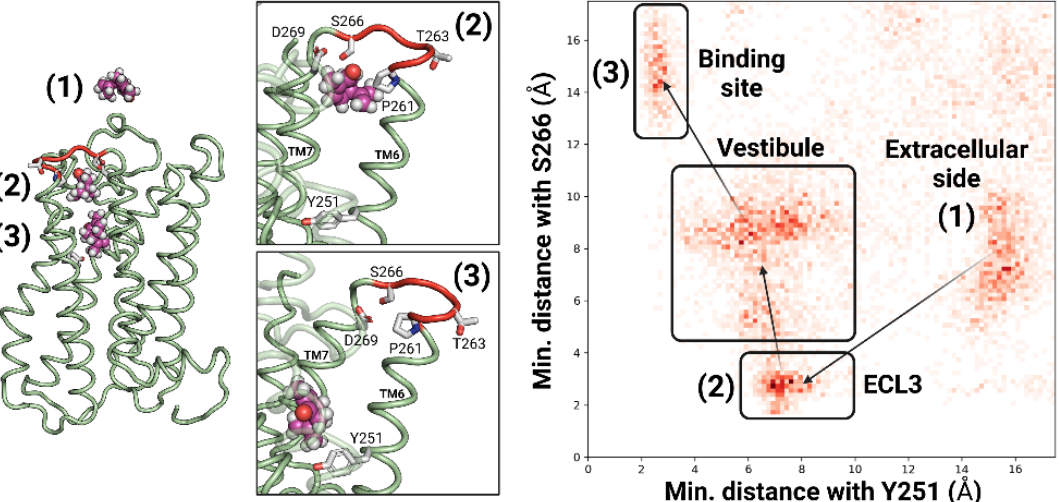
Figure 2. Entry of ( − )-carvone inside receptor hOR1A1. The ligand is initially located outside the receptor (1). It then migrates to the cradle of the orthosteric binding cavity (2,3), as indicated by receptor (1). It then migrates to the cradle of the orthosteric binding cavity (2,3), as indicated by Y251 6.48 . During this process, the ligand interacts with several residues from ECL3 (indicated in red). Y251 6.48 . During this process, the ligand interacts with several residues from ECL3 (indicated in red). Contour map of ( − )-carvone migration as the minimum distance from S266 (taken as the distance Contour map of ( − )-carvone migration as the minimum distance from S266 (taken as the distance from ECL3) and minimum distance from Y251 6.48 (taken as the distance from the cradle of the cavity). from ECL3) and minimum distance from Y251 6.48 (taken as the distance from the cradle of the cavity). All replicas were considered. The three highlighted basins show the ligand ’s largest density. All replicas were considered. The three highlighted basins show the ligand’s largest